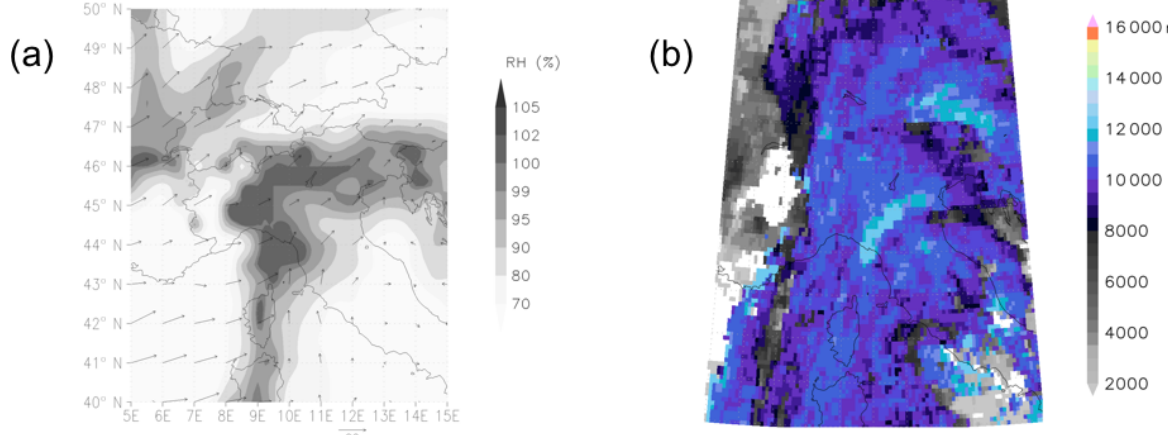
Figure 15. Panel (a) : relative humidity (shaded contours) at 700hPa and mean storm motion (vectors) from GFS analyses on 25 October 2011 at 18:00UTC. Panel (b) : cloud top height from MSG data on 25 October 2011 at